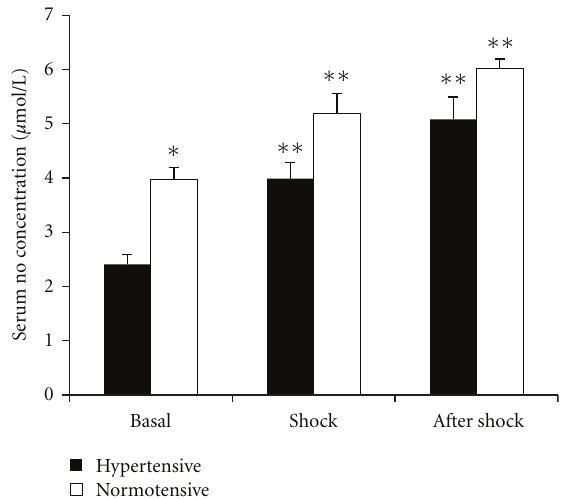
Figure 3: Serum NO concentrations at di ff erent periods in normotensive and hypertensive groups. ∗ Indicates significant dif- ference compared to hypertensive group; ∗∗ indicates significant di ff erences compared to basal